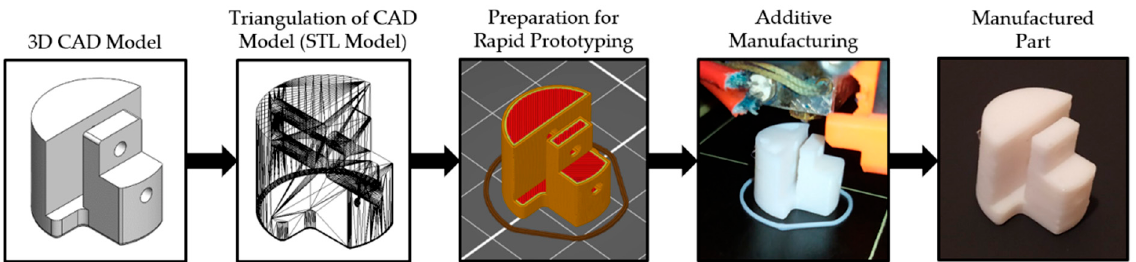
Figure 8. Framework for integrated design and rapid prototyping.